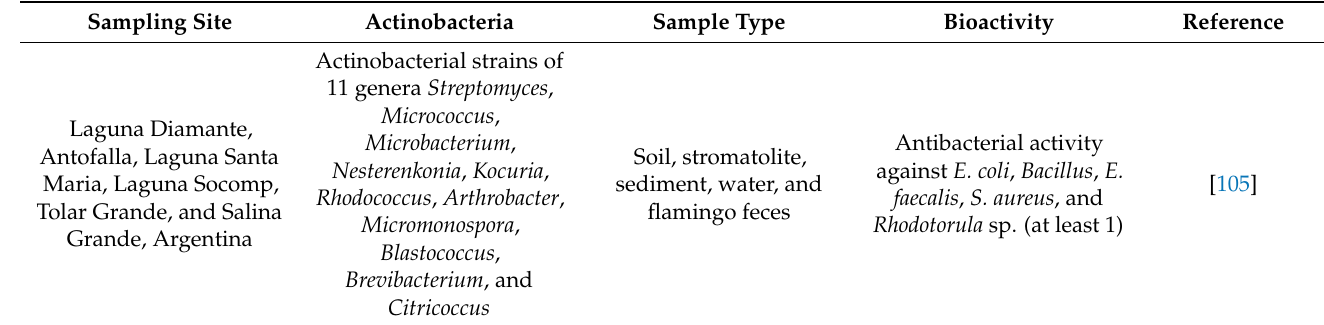
Table 4. Summary of bioactivity of actinobacterial strains isolated from salt